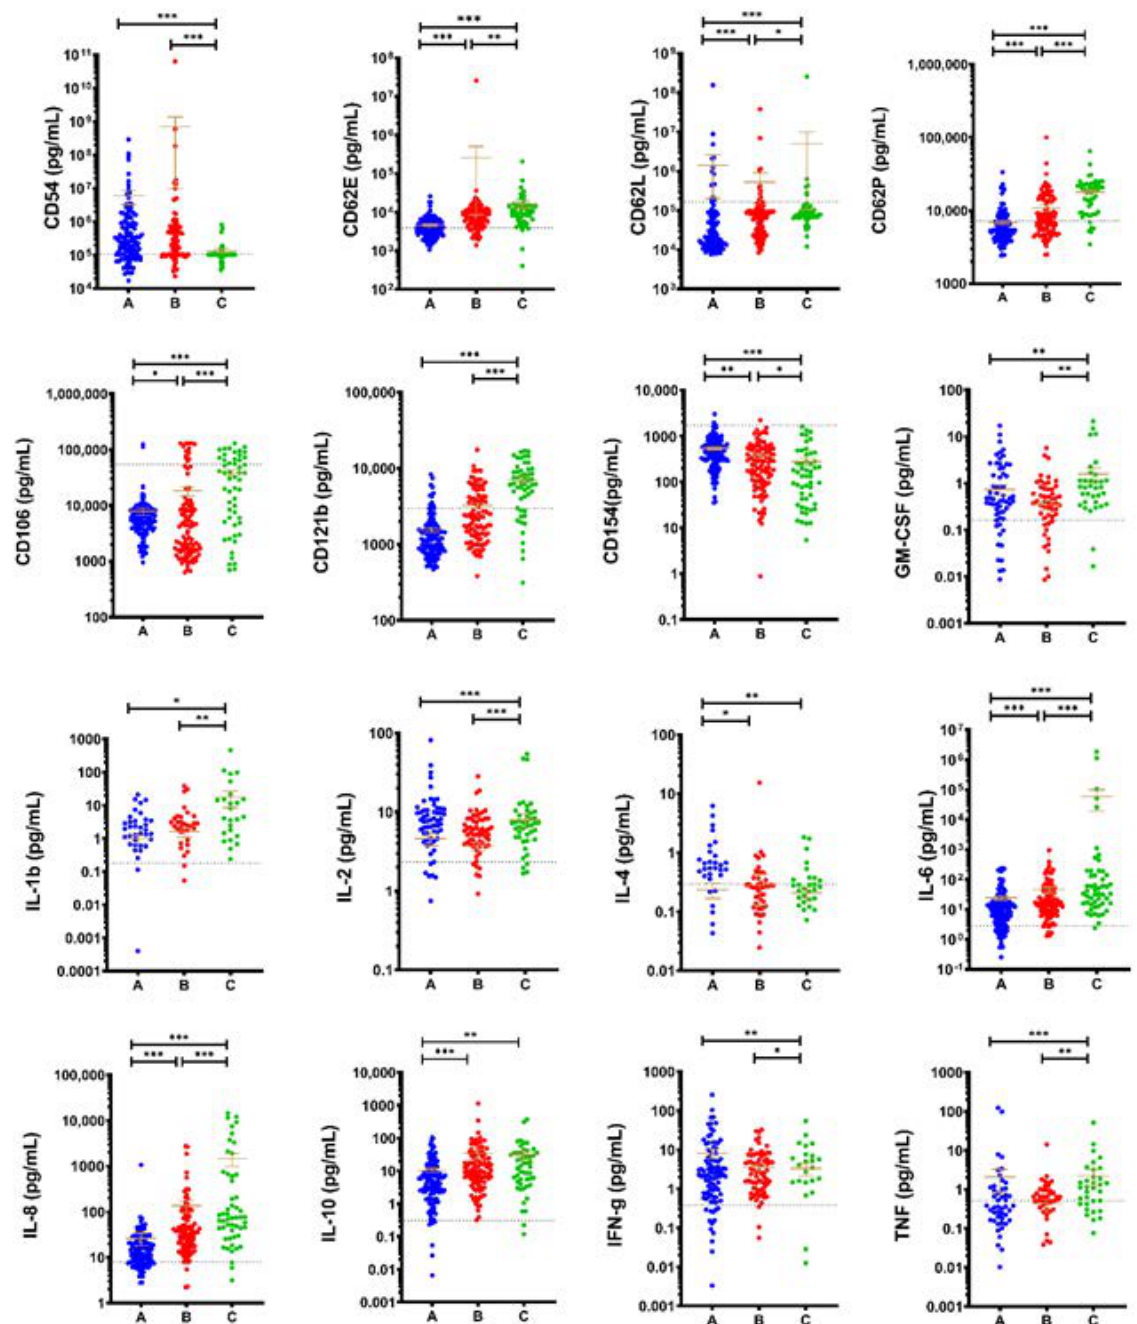
the H and OF group Figure 5A,B and Supplementary Table S1.